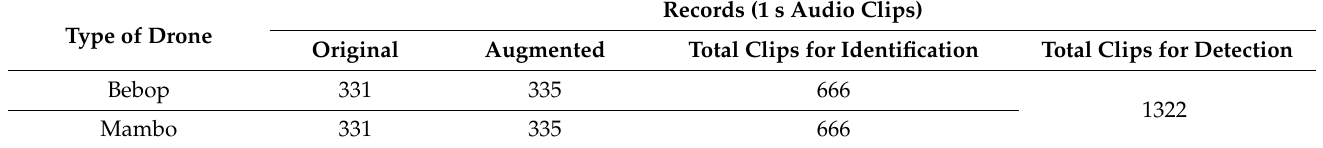
Table 1. Data per label. Type of Drone